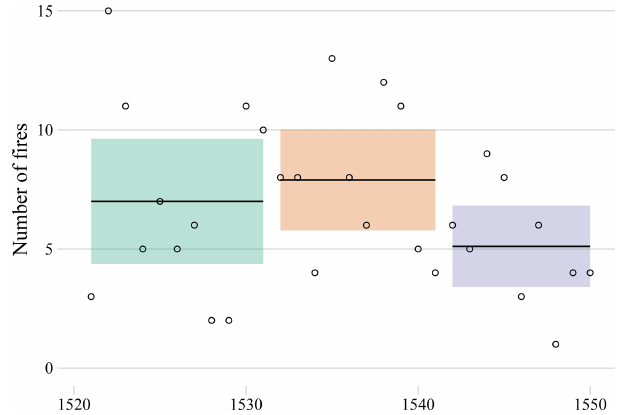
Figure 8. Number of fires registered in Crown Metric. Source: Archival sources AS